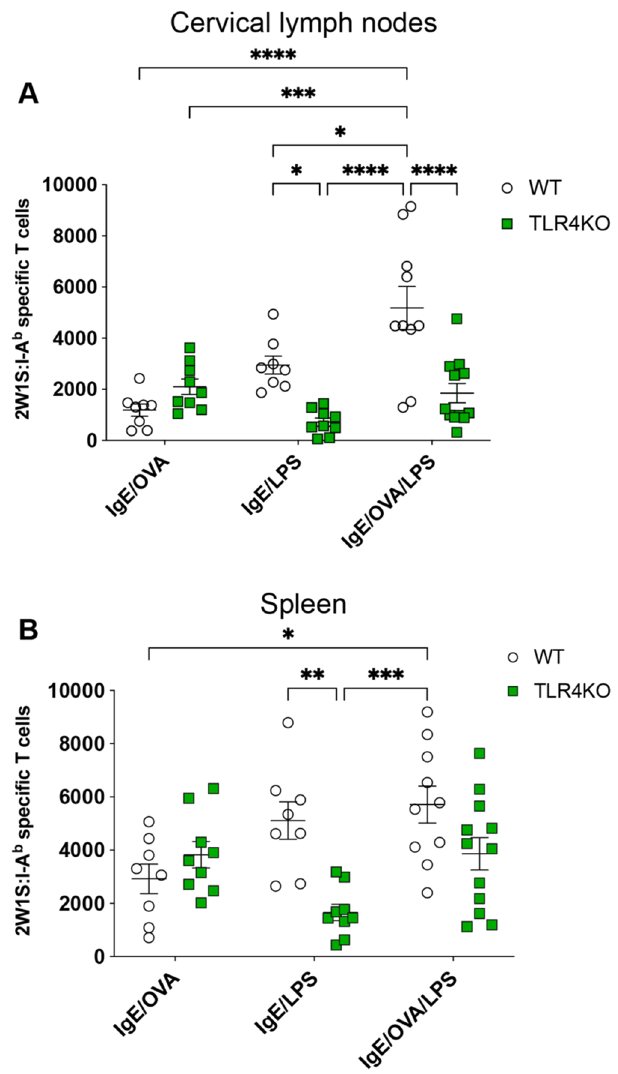
Figure 4. TLR4 activation by LPS is required for enhanced antigen-specific CD4 + T cell response upon IgE/ OVA-induced mast cell activation. ( A , B ) WT or TLR4-deficient mice were immunized with 2W1S peptide, IgE/OVA, LPS, or a combination of IgE/OVA and LPS. Cervical draining lymph nodes ( A ) and spleens ( B ) were analyzed 10 days post immunization for the numbers of 2W1S-specific CD4 + T cells. Results shown are cumulative data from 3 independent experiments n = 8–12 mice and shown as mean ± SEM. * P < 0.05 ** P < 0.01, ** P < 0.001, **** P < 0.0001. Statistical analysis was performed using one-way ANOVA with Tukey’s multiple comparisons